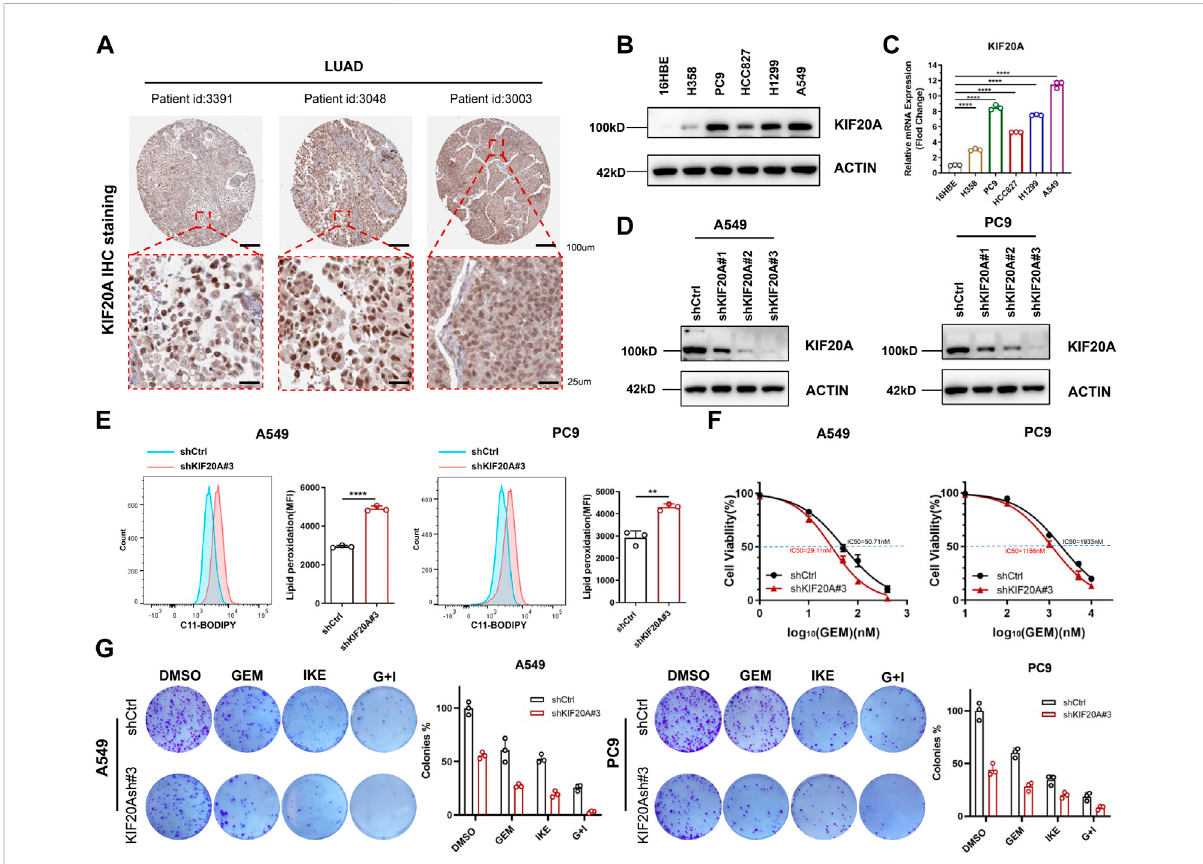
FIGURE 7 KIF20AwashighlyexpressedinLUADcellsandregulatedthecombinedeffectofGEMandIKE. (A) IHCstainingofKIF20AproteininLUADtissues was analyzed based on the HPA database. (B) Western blot analysis was used to detect KIF20A protein levels in human bronchial epithelial-like cells (16HBE)andLUADcelllines(H358,PC9,HCC8217,H1299,A549). (C) RT-qPCRfordetectionofKIF20AmRNAlevelsin16HBEandLUADcelllines. (D) Western blot analysis for detecting knockdown of KIF20A in PC9 and A549. (E) Lipid ROS production was measured by fl ow cytometry using C11-BODIPY. A549/PC9 cells were treated with IKE for 24 h (F) CCK8 assay to detect the IC50 value of GEM in A549/PC9 after KIF20A knockdown. (G) Colony-forming Assay to assess the effect of KIF20A knockdown on the combined IKE and GEM. n = 3. LUAD: lung adenocarcinoma; GEM: Gemcitabine; IHC: Immunohistochemical; RT-qPCR: Real-Time Quantitative PCR; ROS: reactive oxygen species; IKE: Imidazole Ketone Erastin; IC50: half maximal inhibitory concentration; CCK8 assay: Cell Counting Kit-8 assay; G + I: Gemcitabine + IKE. * p < 0.05; ** p < 0.01; *** p < 0.001; **** p < 0.0001; ns p >